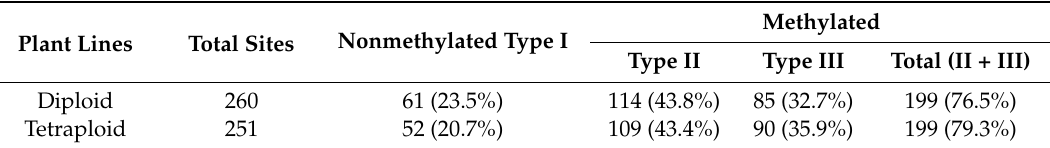
Table 3. Sataus of cytosine methylation in the autopolyploid.